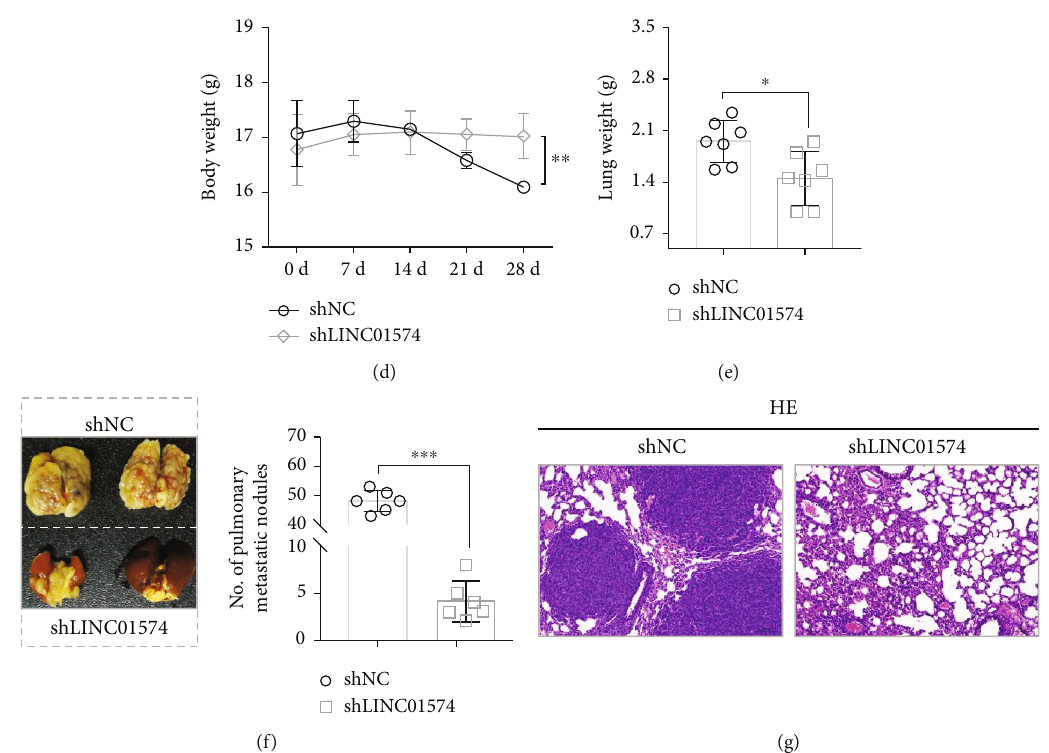
Figure 3: Knockdown of LINC01574 inhibited BC tumor metastasis in vitro and in vivo . (a, b) After being transfected with shNC or shLINC01574, the migration and invasion capabilities were assessed. (c) EMT-related proteins were detected by western blot. (d, e) In the lung metastasis model, the body weight and tumor weight of nude mice were measured. (f, g) Lungs H&E staining. ∗ P < 0 : 05 , ∗∗ P < 0 : 01 , and ∗∗∗ P < 0 : 001